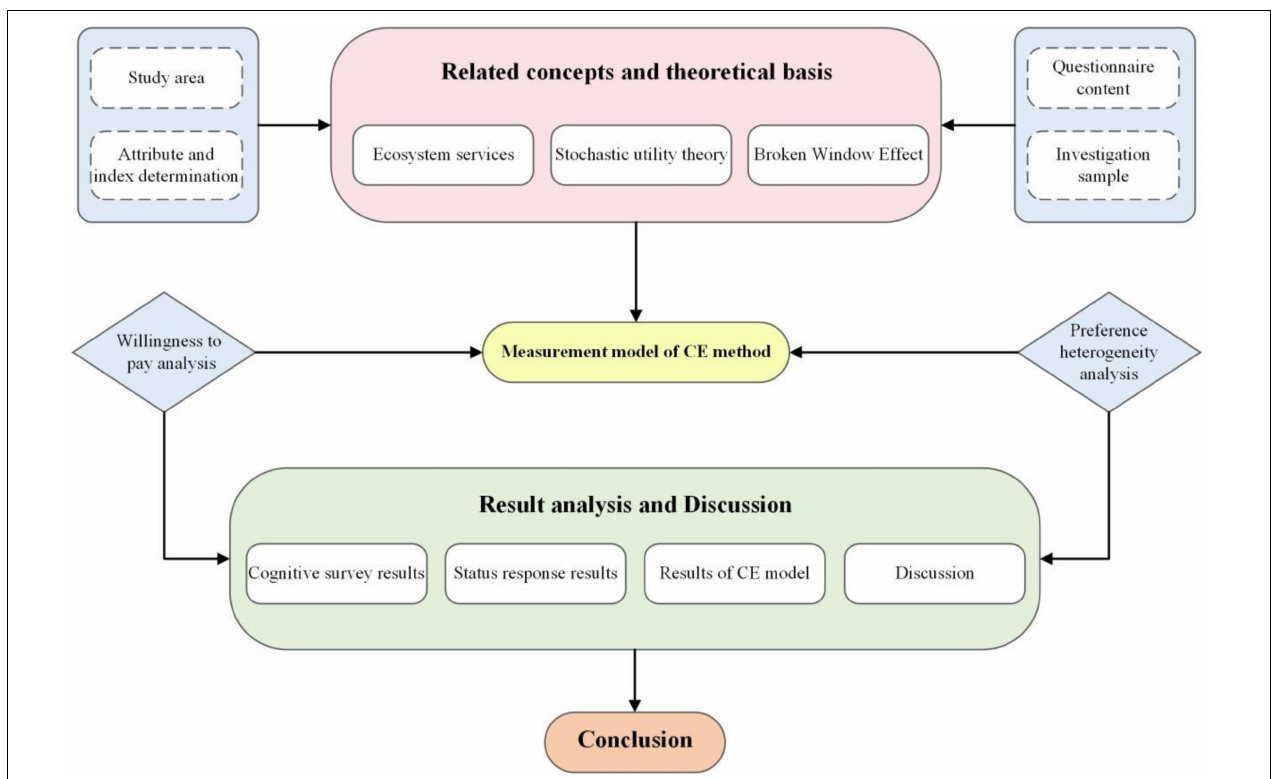
FIGURE 1 | Theoretical analysis